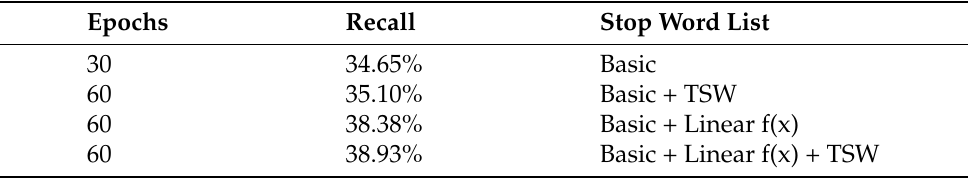
Table 4. Experiment results of LSTM.